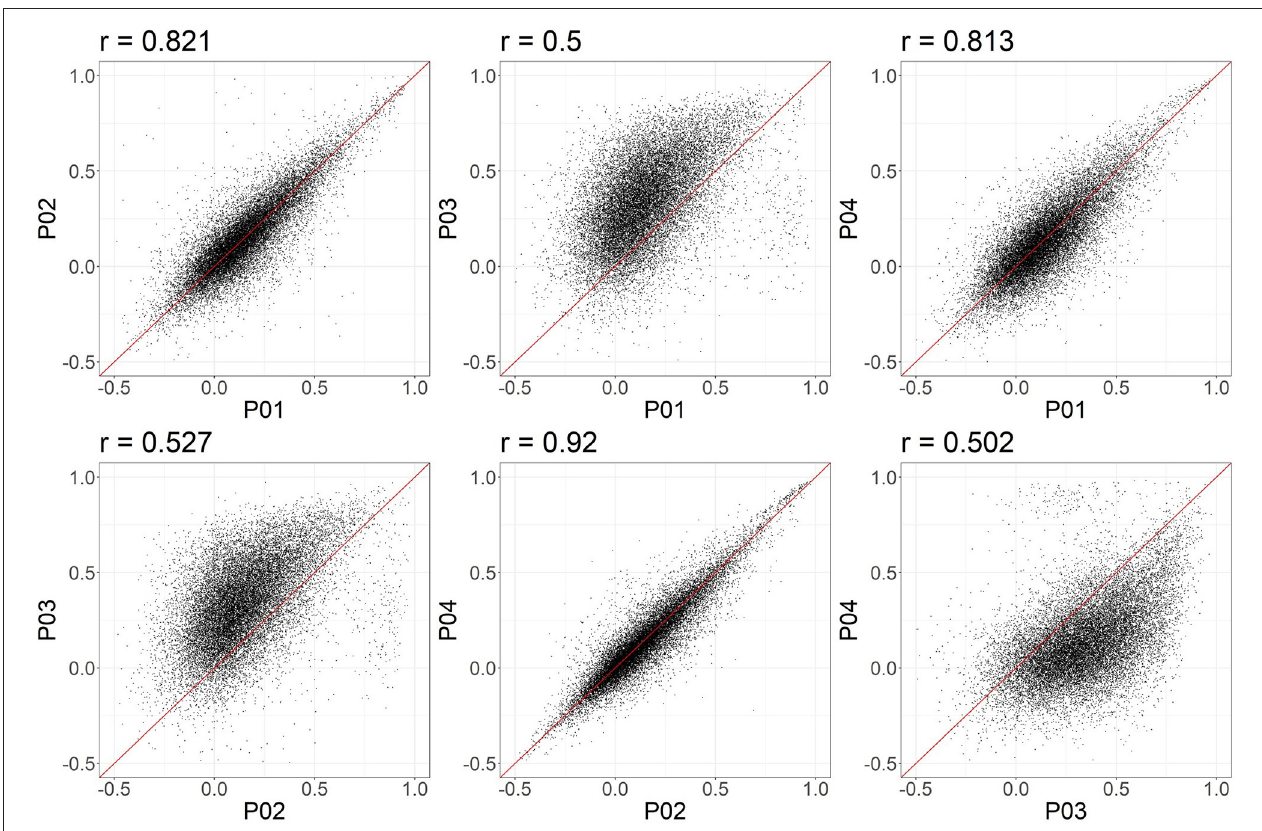
FIGURE 5 | Node-to-node correlations measured for individual subjects. Each point represents the connectivity measured for one pair of ROIs and one subject, with the X and Y values representing the connectivity measured obtained with two different pipelines. 20,000 points were randomly sampled for